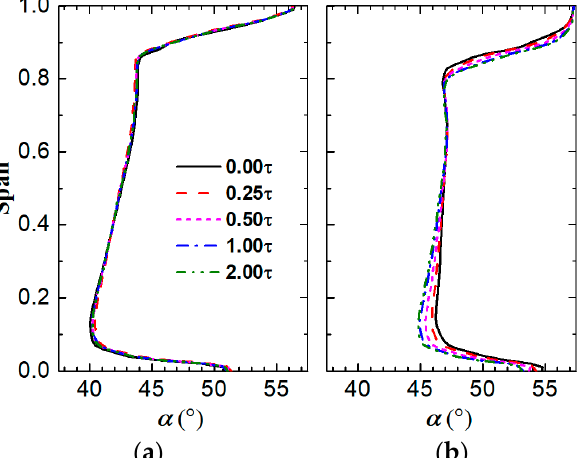
Figure 20. Circumferentially averaged flow yaw angle at stator inlet. ( a ) In the DE condition; ( b ) in the NS condition.